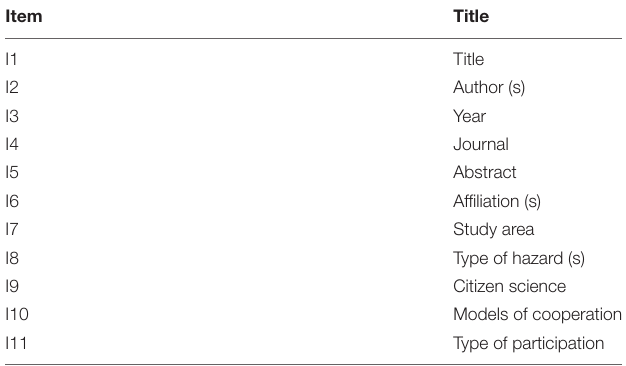
TABLE 4 | Extracted